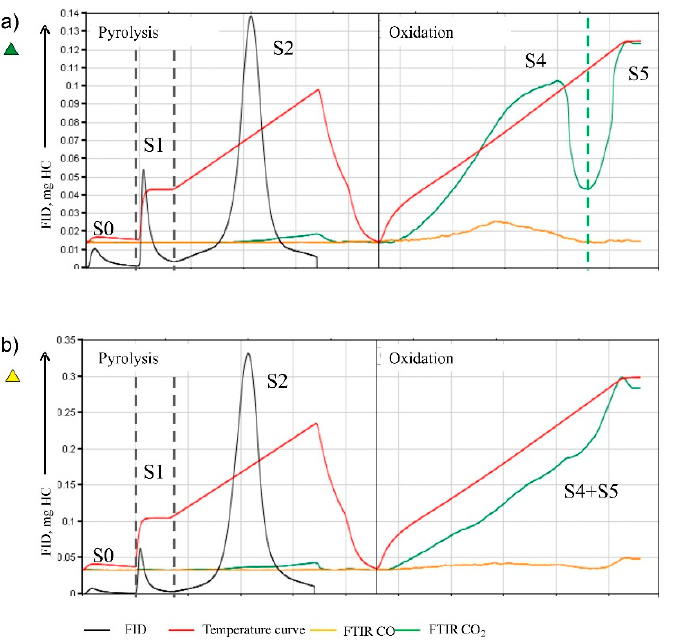
Figure 5. Examples of pyrogram for a sample with ( a ) incompletely separated S4 and S5 peaks (unit D5) and ( b ) superimposed peaks S4 and S5 (unit D4), (green triangle—samples of non-distinct separation of the peaks S4 and S5; yellow triangle—fully superimposing S4–S5).